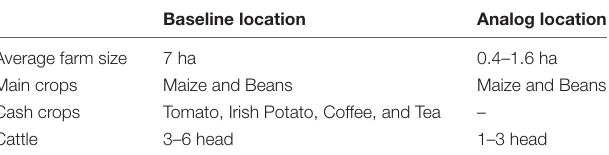
TABLE 1 | Site characteristics at the baseline and analog